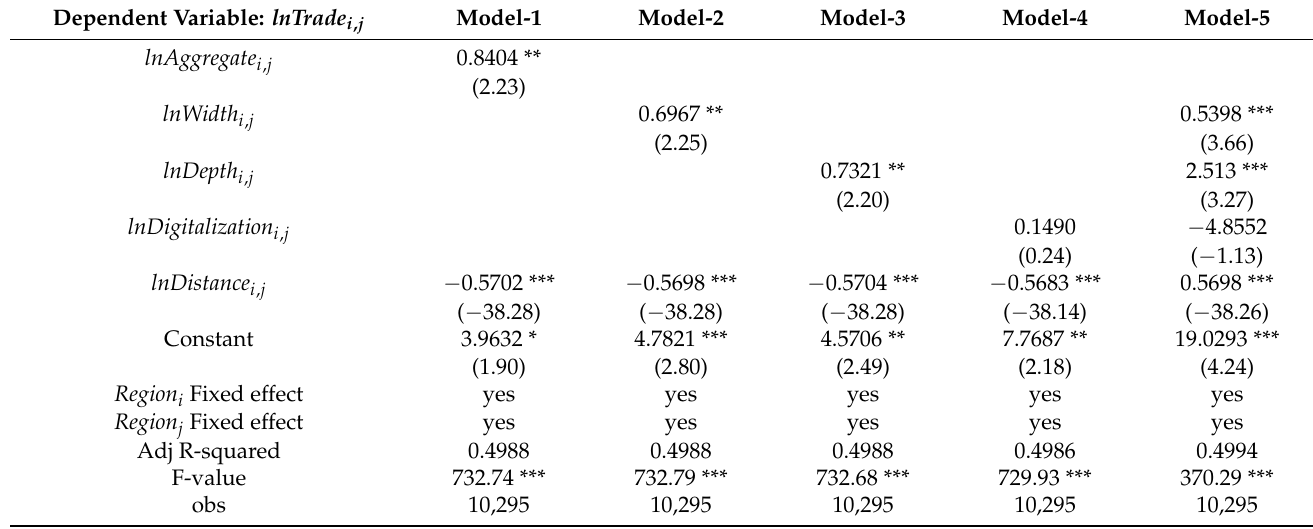
Table 3. Results of Log-Log regression model with fixed effects (LL-FE).